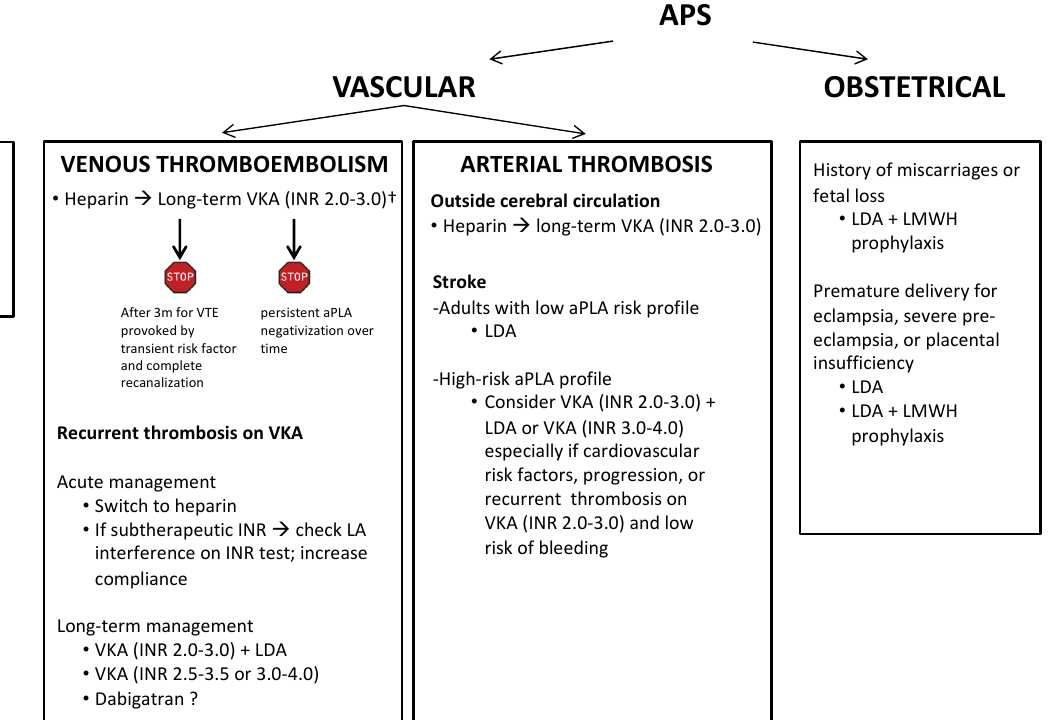
Figure 2. Recommendations for the management of antithrombotic prophylaxis and treatment in antiphospholipid syndrome. APS, antiphospholipid syndrome; aPLA, antiphospholipid antibodies; LDA, low dose aspirin; LMWH, low molecular weight heparin; VTE, venous thromboembolism; VKA, vitamin K antagonist; INR international normalized ratio; LA, lupus anticoagulant; CV cardiovascular. * postoperative periods, lower limb fracture, immobilization, hospitalization, central venous catheter, pregnancy/puerperium. † DOAC (dabigatran preferred) can be considered in patients with single or double aPLA positivity (2019 EULAR; 2020 BSH; 16th International Congress on Antiphospholipid Antibodies Task Force Report on Antiphospholipid Syndrome Treatment Trends).